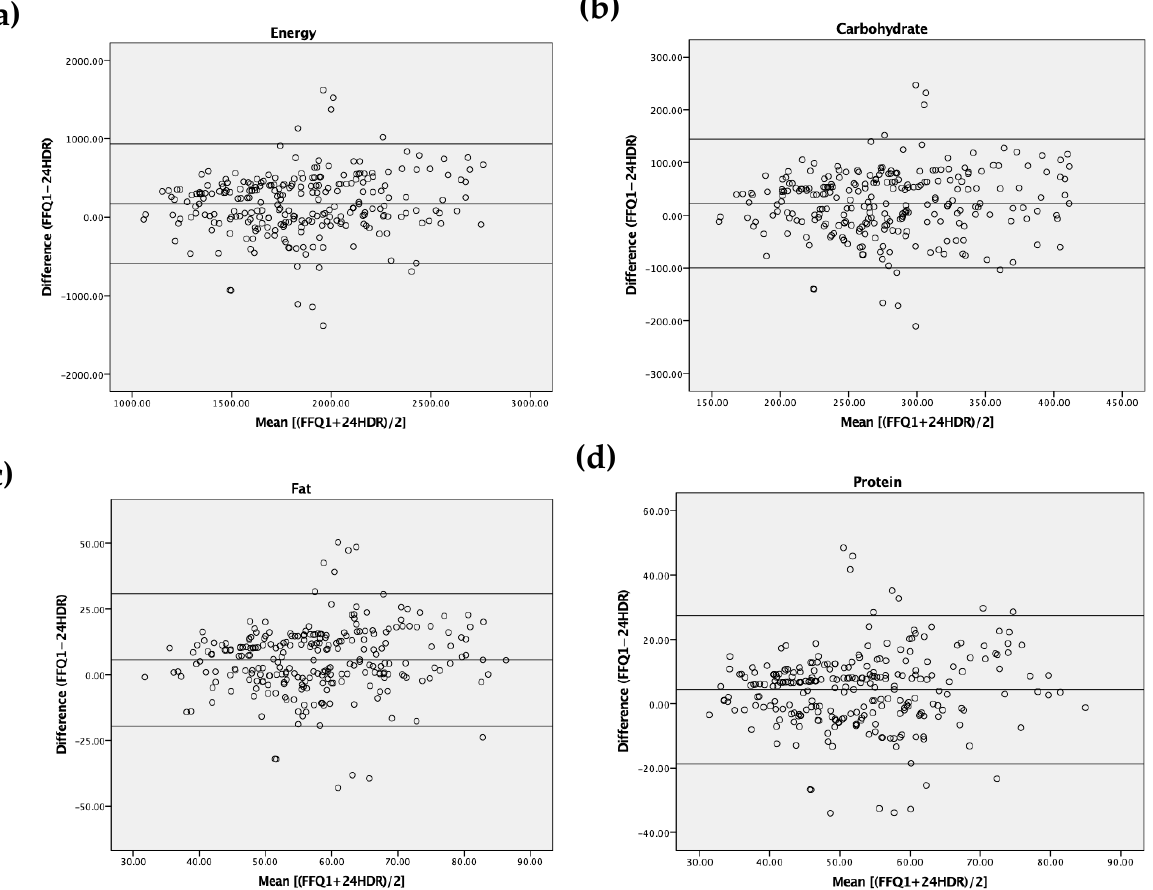
Figure 2. Bland-Altman plots for the intakes of energy (kcal) ( a ), carbohydrate (g) ( b ), fat (g) ( c ) and protein (g) ( d ). The difference between the mean estimate of energy and macronutrient intakes by two dietary assessment methods ( y -axis) was plotted against the mean of nutrients measured by two dietary assessment methods ( x -axis). FFQ: food frequency questionnaire, 24HDR: 24 h dietary recall.